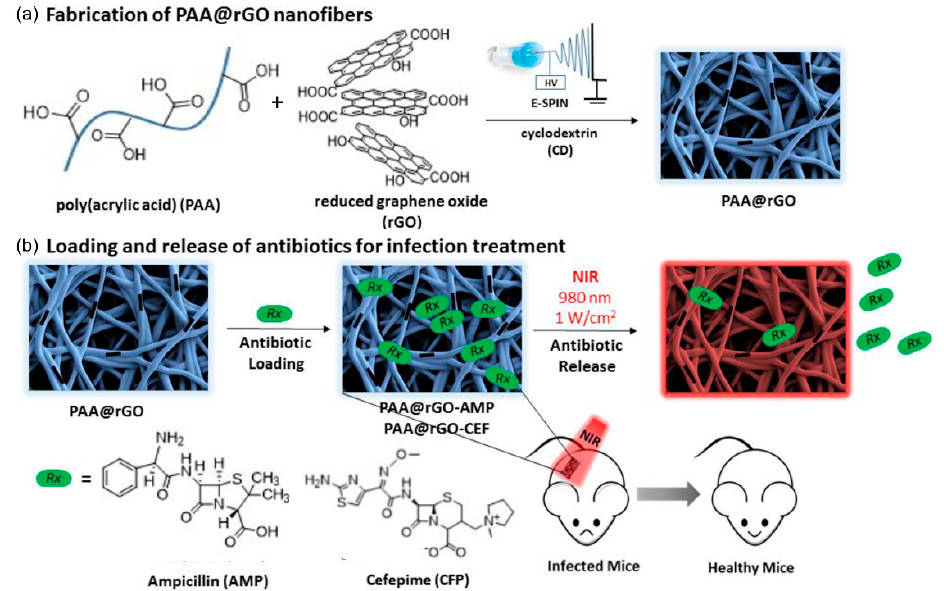
Figure 12. Schematic of ( a ) electrospinning of rGO-loaded PAA NF mats followed by ( b ) loading with different antibiotics and photothermal triggered antibiotic release. Reproduced with permission from [91], Copyright © 2021, American Chemical Society.